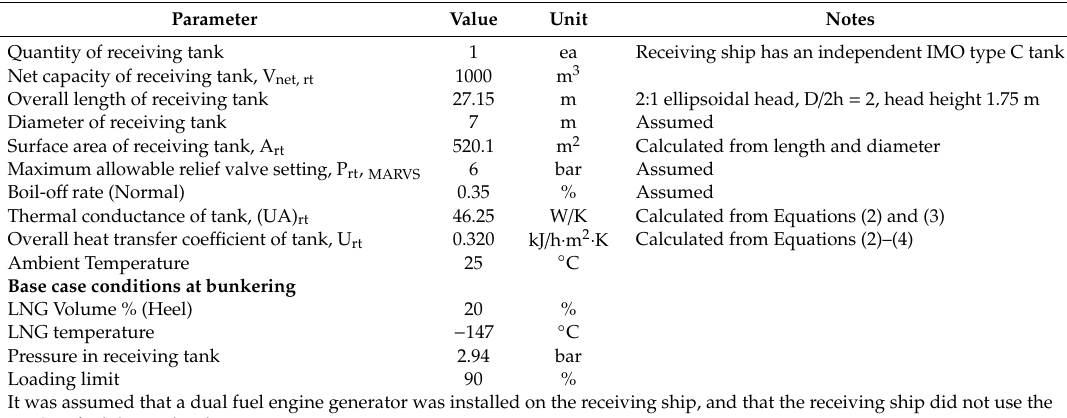
Table 3. Specification and initial condition of LNG fuel tank in receiving ship.